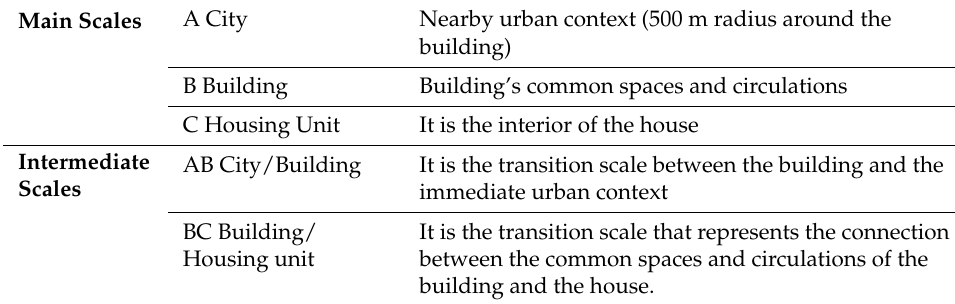
Table 1. Scales of analysis. Source own